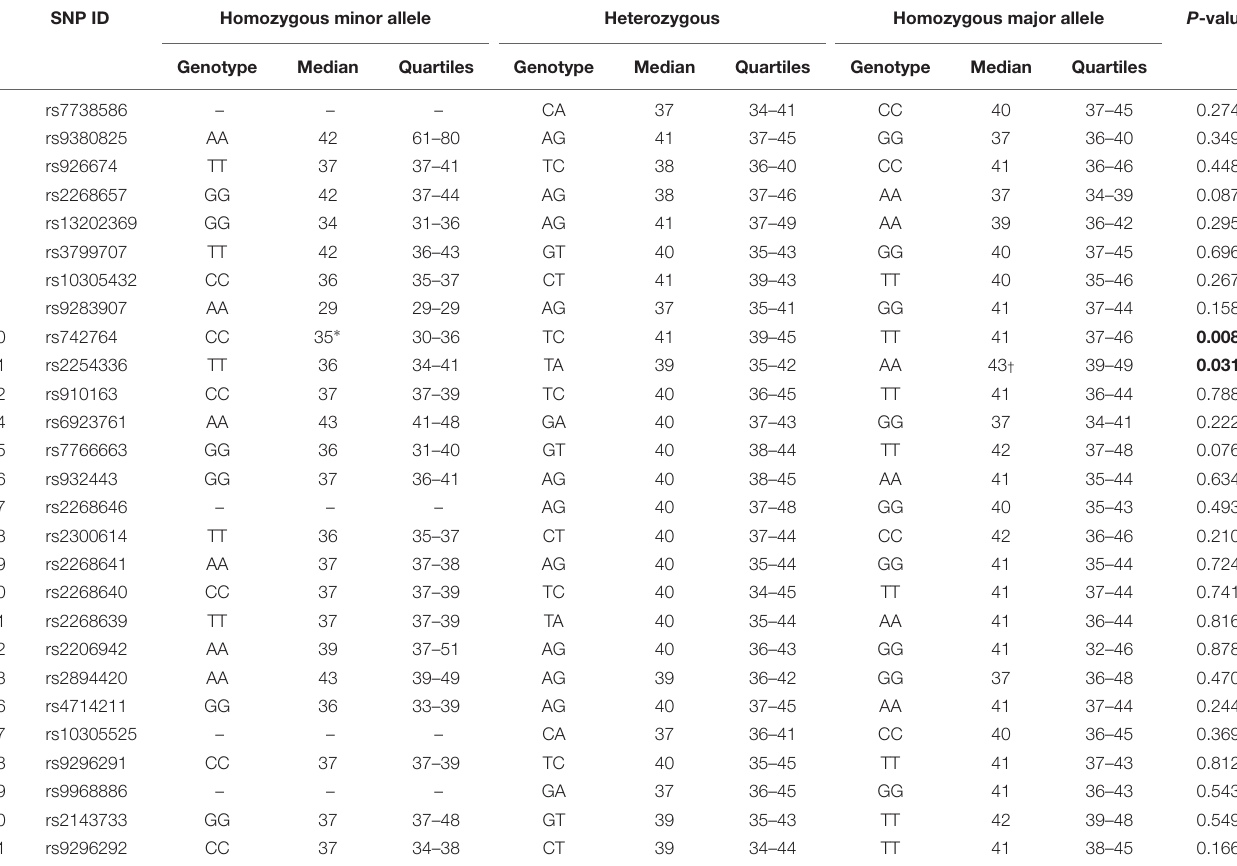
TABLE 3 | Gastric emptying T lag results according to